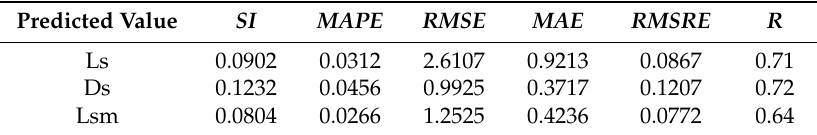
Table 5. The statistical performance of MARS models during validation period in prediction of Ls, Ds and Lsm using non-dimensional data.